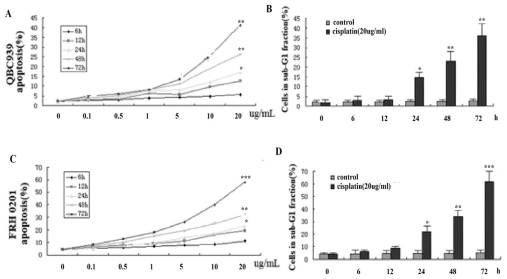
Cisplatin-induced apoptosis in QBC939 and FRH 0201 cells. A, C, QBC939 and FRH0201 cells (1 × 106/mL) were exposed to the designated concentrations of cisplatin for the indicated times, after which time the percentage of apoptotic cells was determined by flow cytometric analysis, as described in “Materials and Methods”. The data are expressed as a mean value of the percentage of apoptotic cells from three independent experiments performed in duplicate (*P < 0.05, **P < 0.01, ***P < 0.001). B, D, At the indicated time points after treatment with 20 μg/mL cisplatin, the cells were harvested and fixed in 70% ethanol. After staining with PI, the apoptotic DNA content was analyzed by flow cytometry. The number of apoptotic cells in the sub-G1 fraction is expressed as a percentage of the total number of cells (*P < 0.05, **P < 0.01, ***P < 0.001).